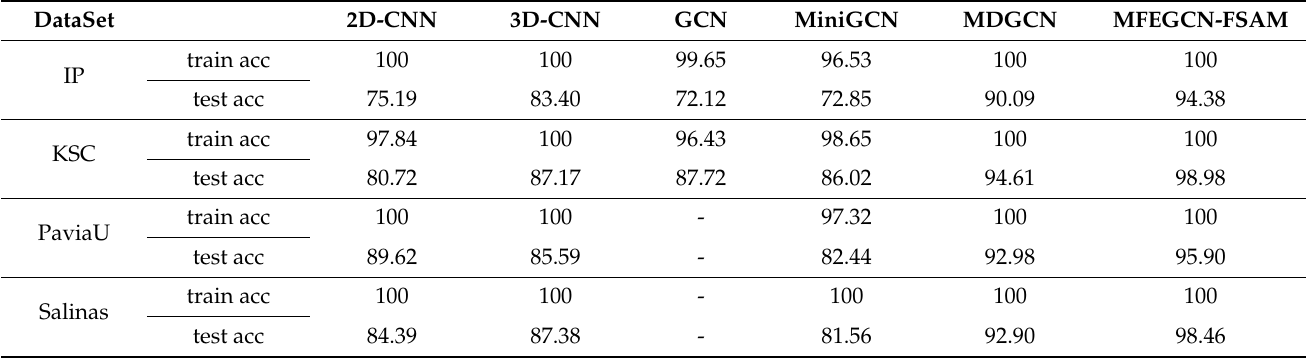
Table 11. Training Accuracy and Testing Accuracy of different